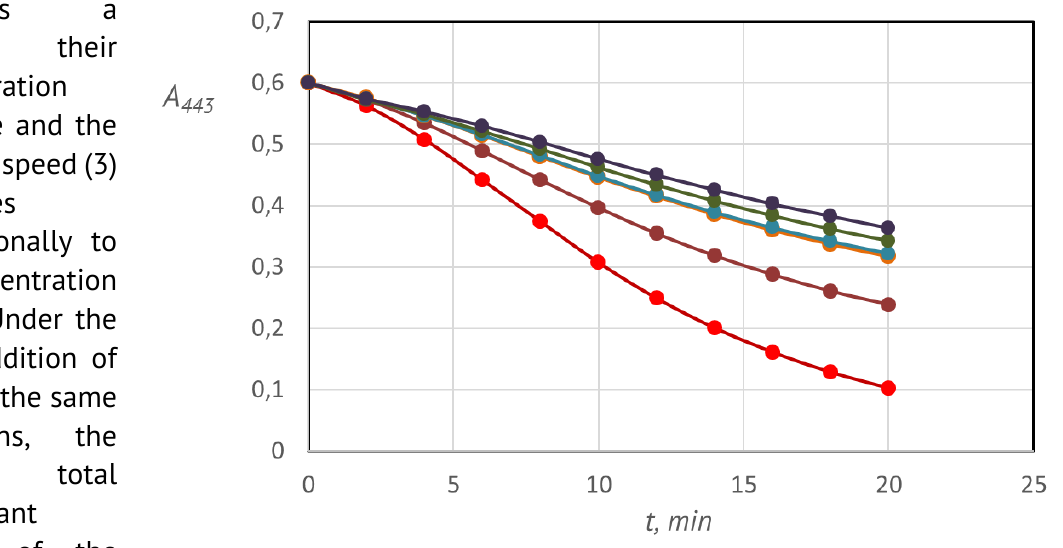
Figure 7. The kinetic curves of crocin oxidation (443 nm) in the absence (Ch-0) and in the presence in the reaction mixture of various amounts of Chardonnay wine: 0,15; 0,30; 0,45; 0,60 and 0,90 ml / 4 ml of the reaction mixture.Thermal initiation of peroxy radicals using